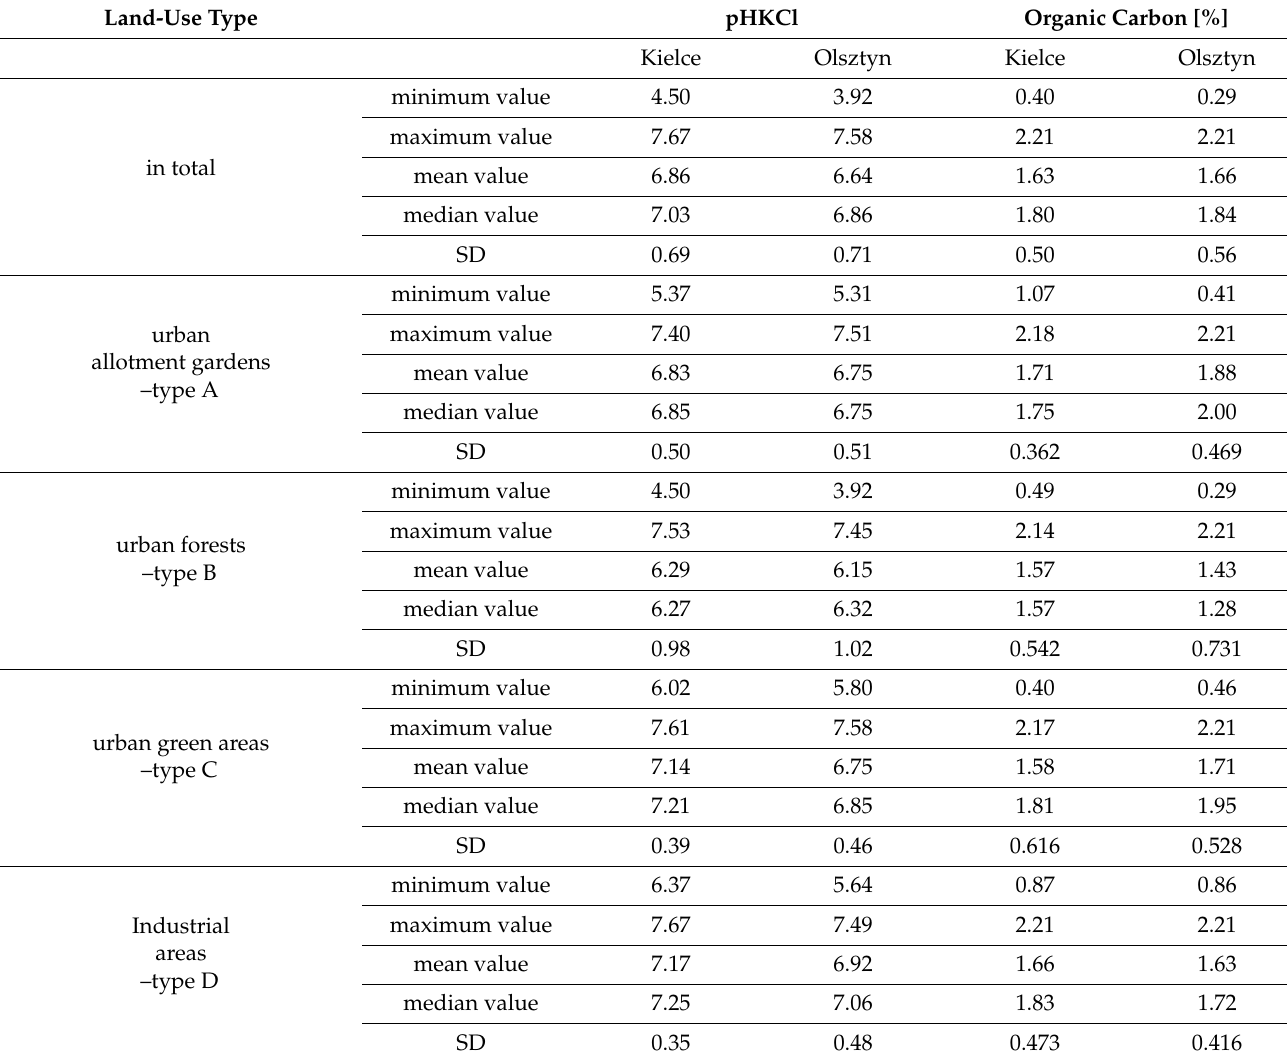
Table 3. Statistics concerning the physico-chemical properties of the studied soils in Kielce and Olsztyn with regard to land-use